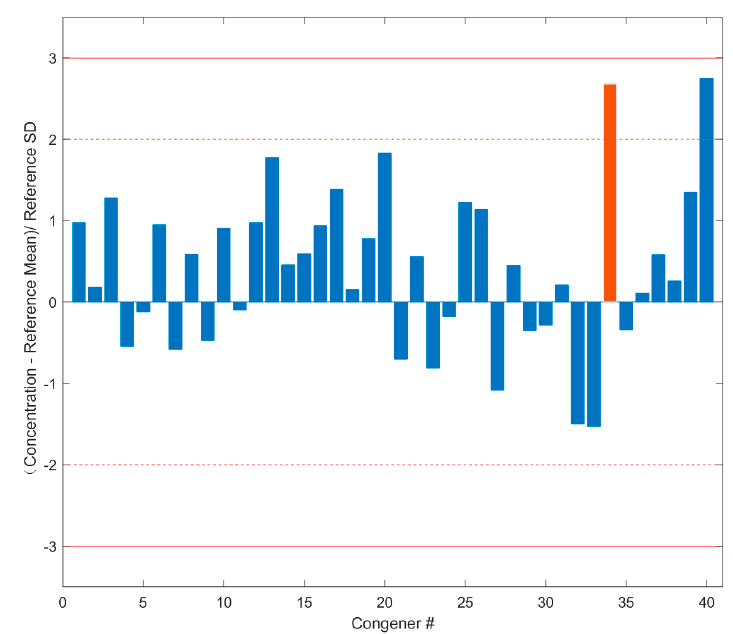
Figure 3. Concentrations of congeners in Standard Data. The differences in concentrations of the 40 congeners between Standard Data and corresponding mean concentrations in Standard Reference are transformed by standardization scaling to the standard deviations calculated from Standard Reference and are plotted on the y axis. The x axis indicates the congener numbers that are given in Supplementary Table S1. The dashed lines give the region within two standard deviations, and the solid lines depict the region within three standard deviations. The red bar represents the scaled concentration of congener 13 C-OCDD.